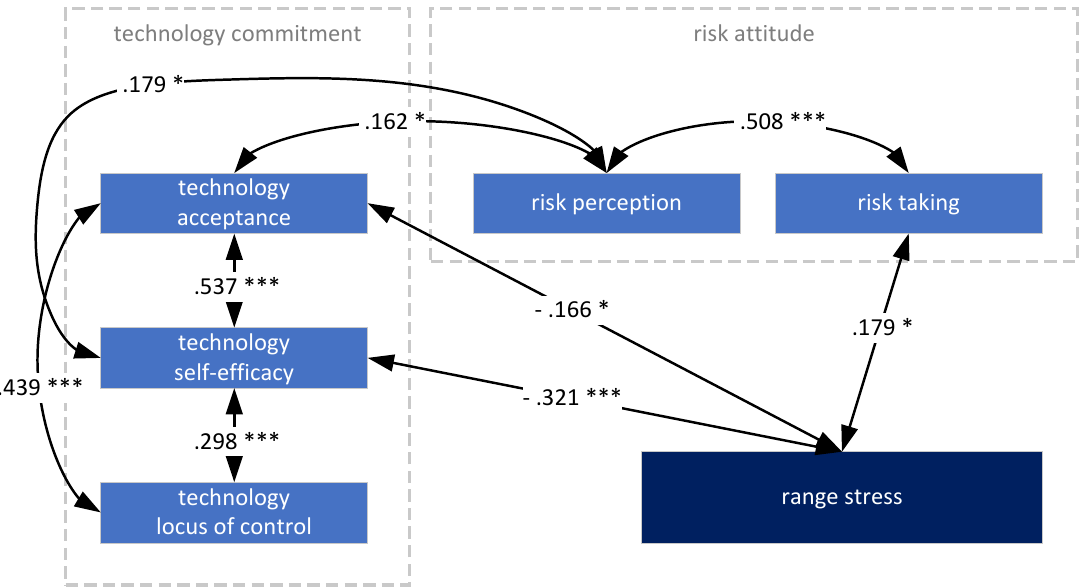
Figure 6. Pearson correlation coefficients for range stress, risk attitude, and technology commitment (* corresponds to p < .05, *** corresponds to p <